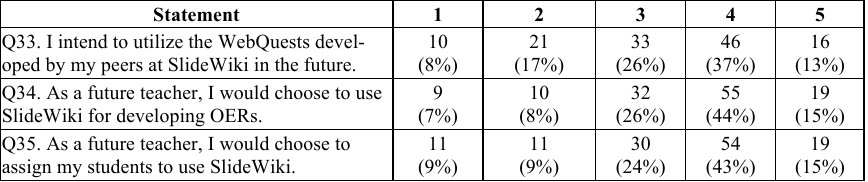
Table 6. Distribution of the students’ responses in statements Q33 to Q35 of Section D Statement 1 2 3 4 5